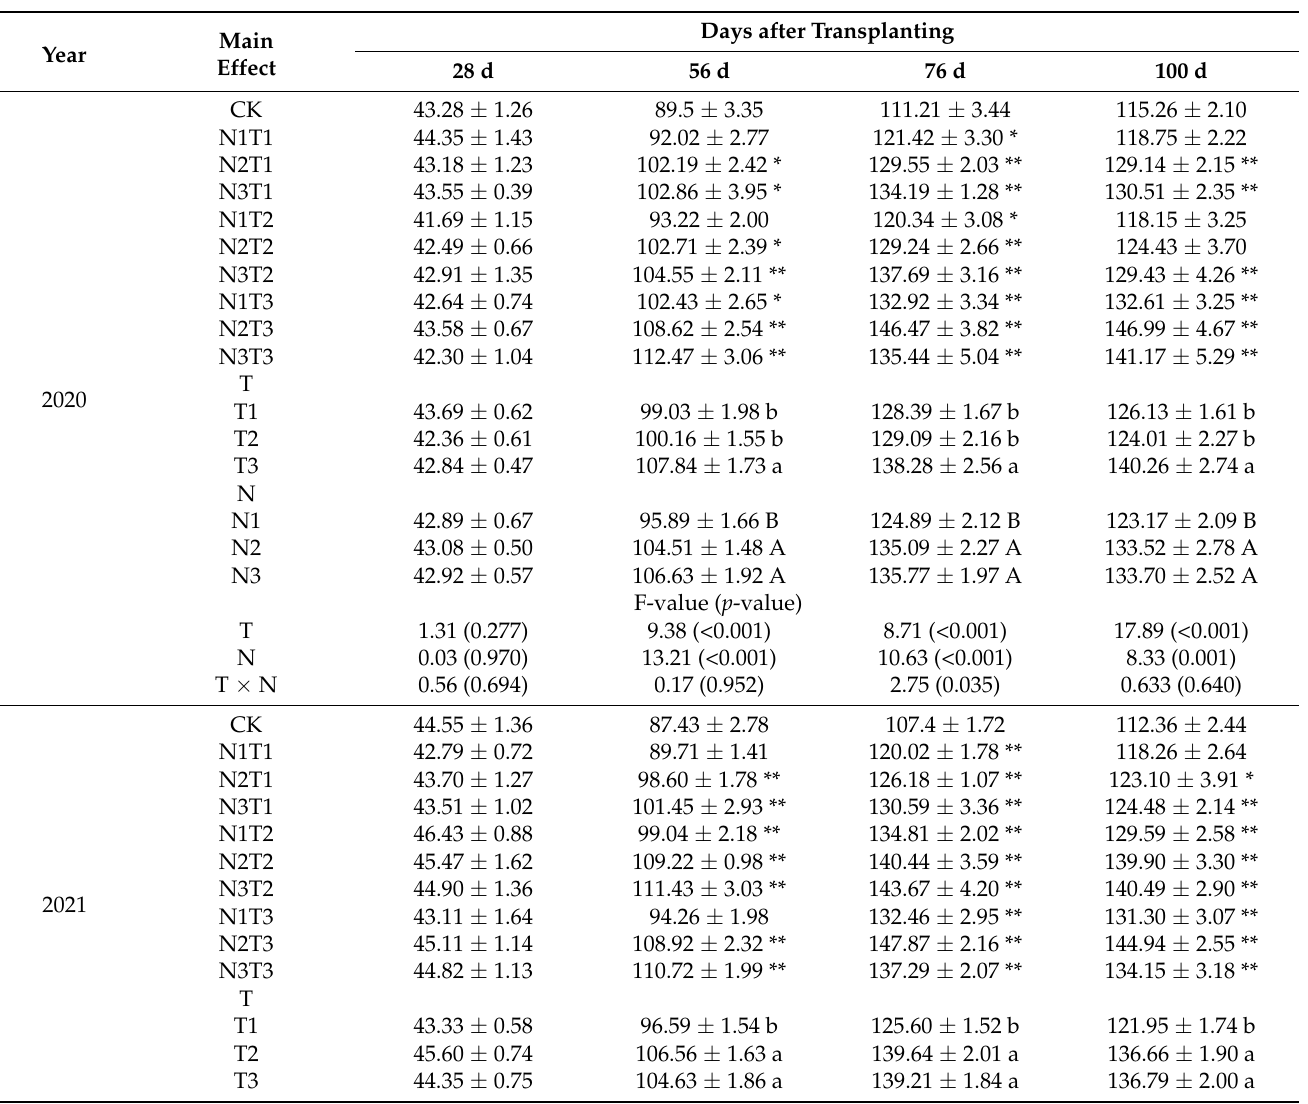
Table 4. Response of tomato plant height (PH, cm) to different urea types and N application rates in the